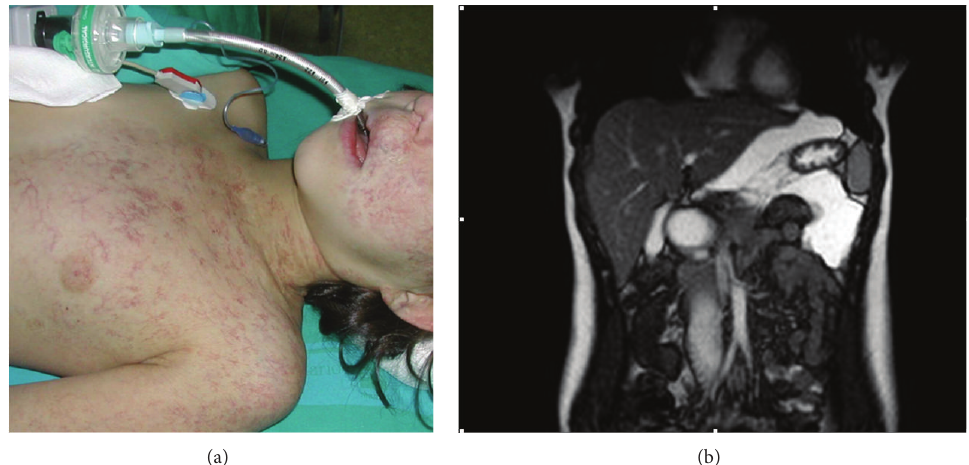
Figure 1: Left angiomatous cervicofacial and thoracic hemangioma plaque and lymphatic mesenteric malformation that surrounded stomach and spleen inferior pole.